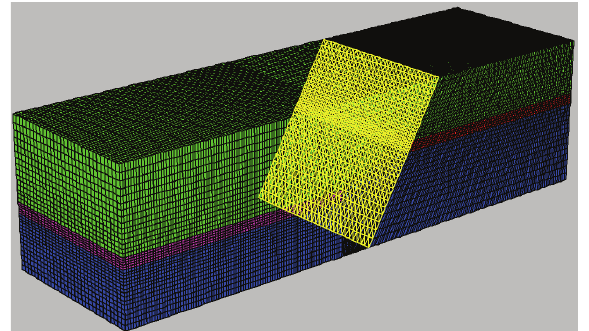
Figure 7: Numerical